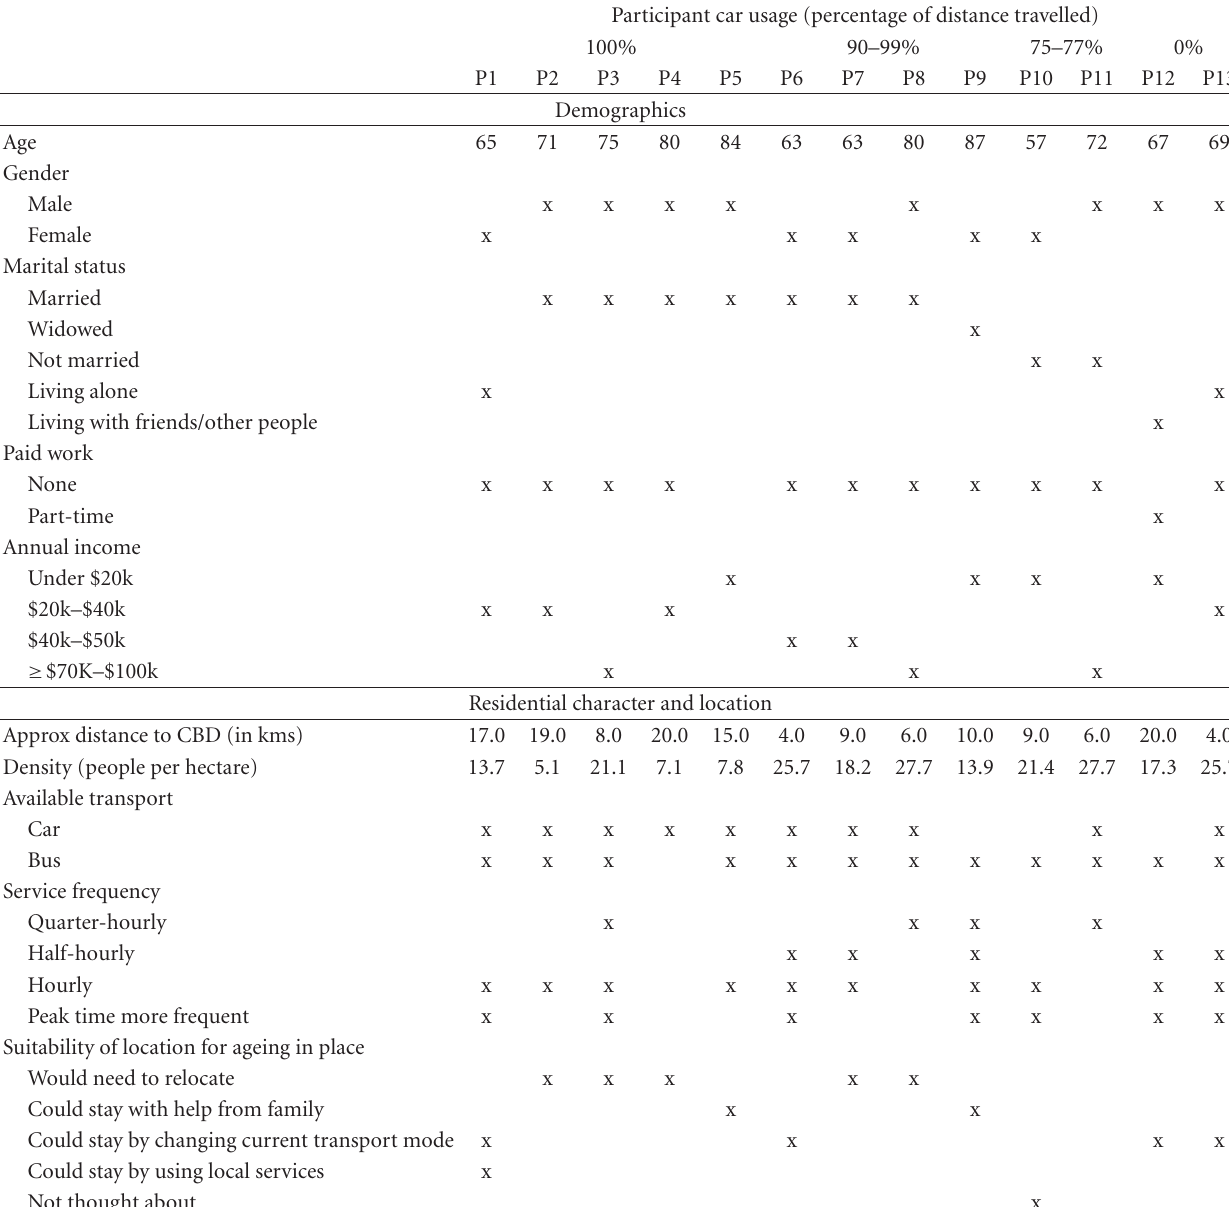
Table 1: Demographic characteristics, residential character, and